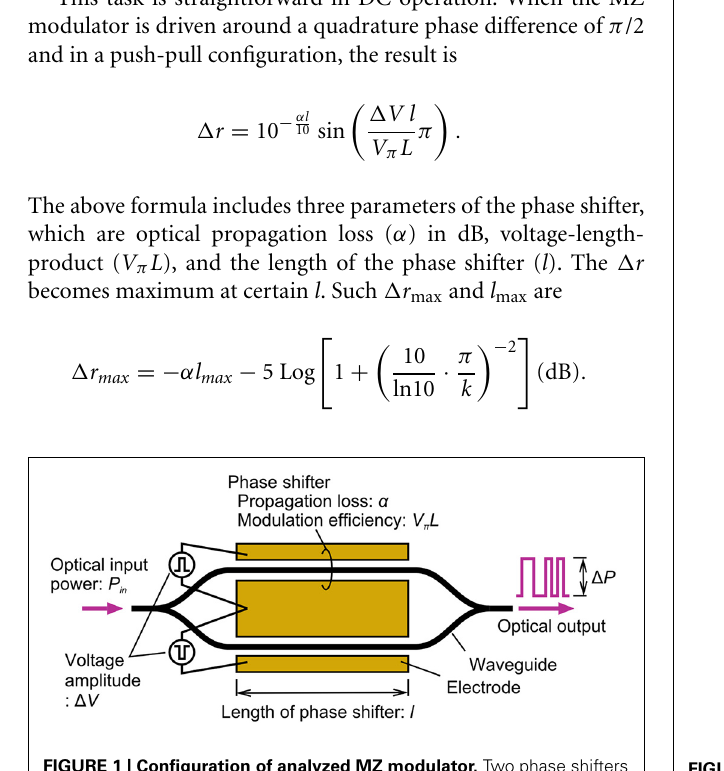
FIGURE 2 | (A) Product of propagation loss and length of phase shifter at which maximum (cid:4) r is obtained, as function of k = α · V π L /(cid:4) V . (B) Maximum (cid:4) r obtained from modulator as function of k